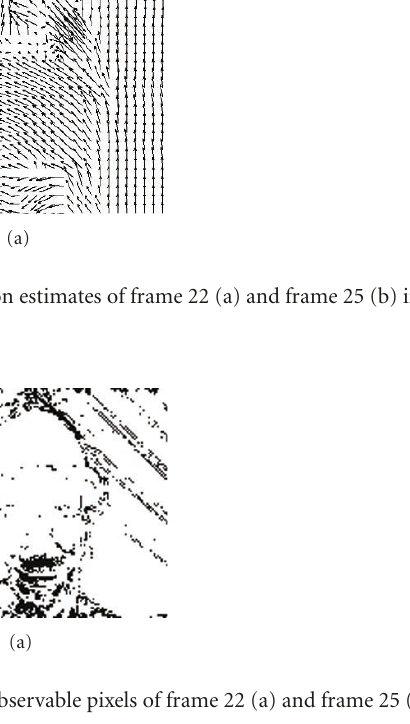
frames in the video with a downsampling factor of two. Here, we again demonstrate the reconstruction results of frame